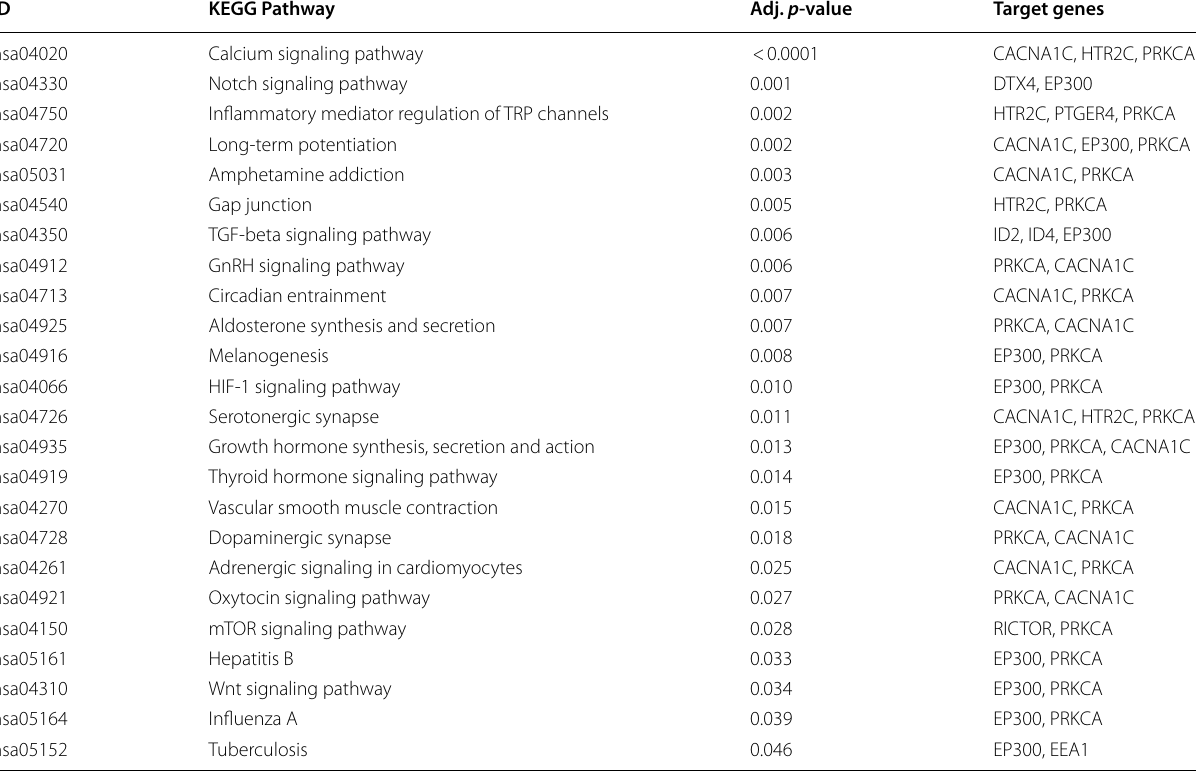
Adj. p -value are the lowest enrichment p -value obtained through multiple iterations. The target genes are the predicted genes (targets of at least one DE miRNA) involved in the given enriched pathway KEGG Kyoto Encyclopedia of Genes and Genomes, Adj. p-value adjusted p-value corrected for multi-testing using the Benjamini–Hochberg procedure